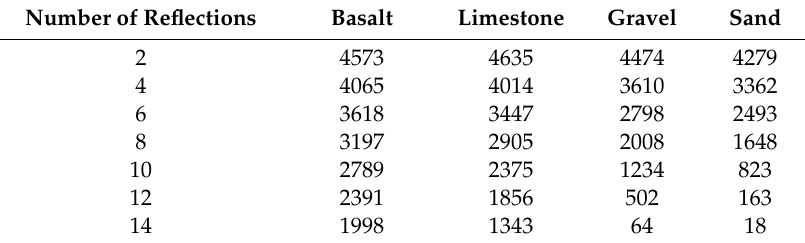
Table 6. Results of lifetime for di ff erent materials.